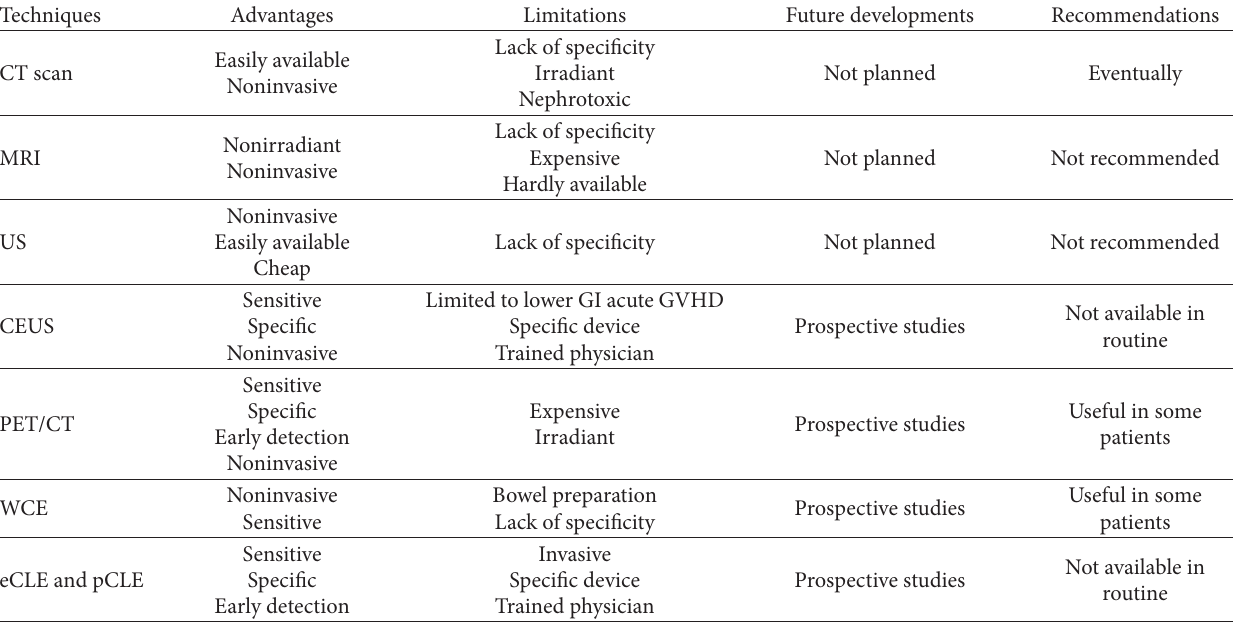
Table 1: Advantages, limitations, future developments and recommendations for the use of each technique.